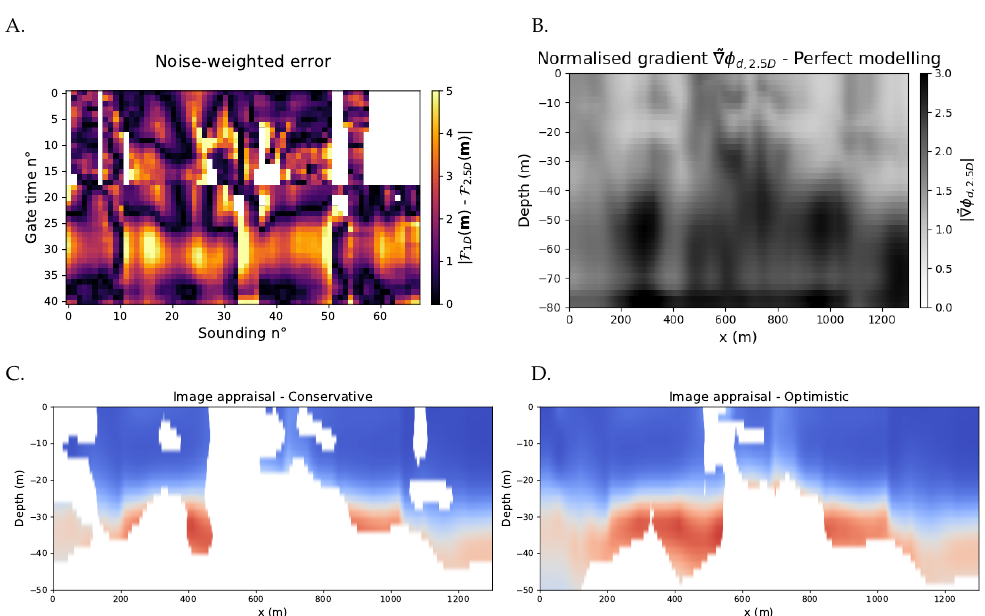
Figure 6. Image appraisal on real field data with perfect forward modeling approach. The individual noise-weighted errors in ( A ) include observed noise. The normalised gradient ( B ) for different cut-off values are shown in ( C , D ).